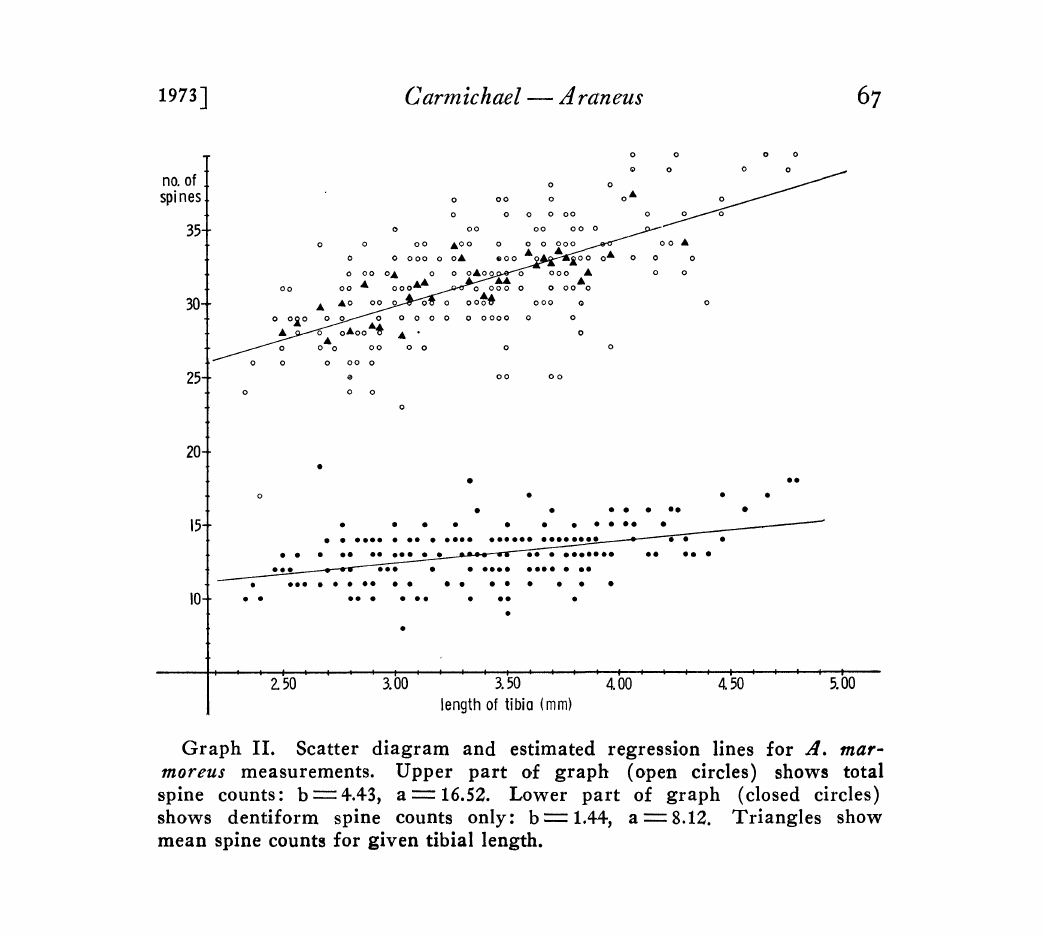
Graph II. Scatter diagram and estimated regression lines for At. mar- moreus measurements. Upper part of graph (open circles) shows total spine counts" b--4.43, a m16.52. Lower part of graph (closed circles) shows dentiform spine counts only: b ul.44, areS.12. Triangles show mean spine counts for given tibial